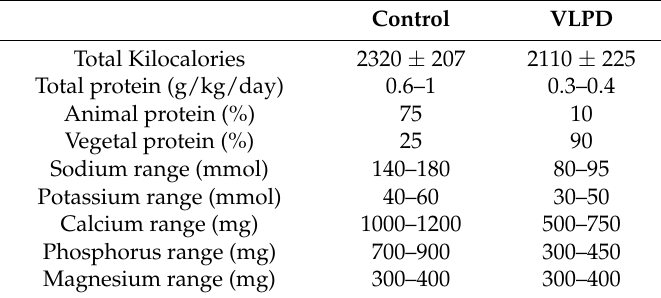
Table 1. Diet’s composition of the two